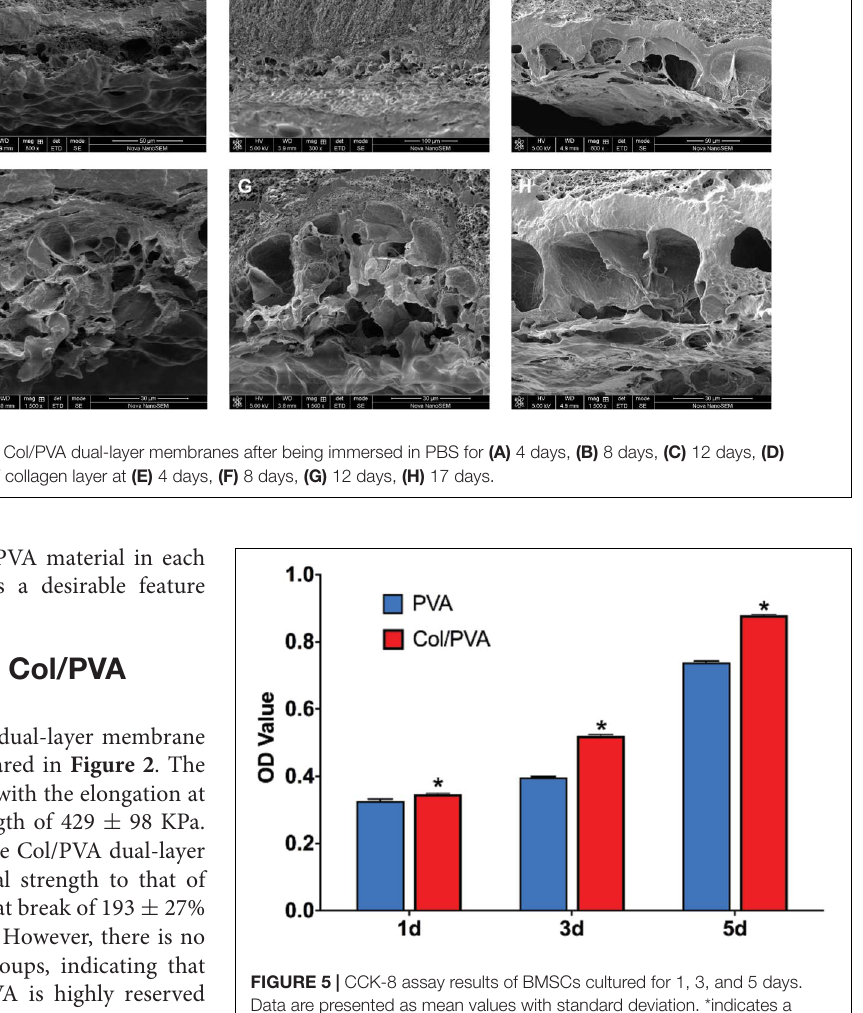
FIGURE 5 | CCK-8 assay results of BMSCs cultured for 1, 3, and 5 days. Data are presented as mean values with standard deviation. *indicates a significant difference between Col/PVA and PVA group with p -value <